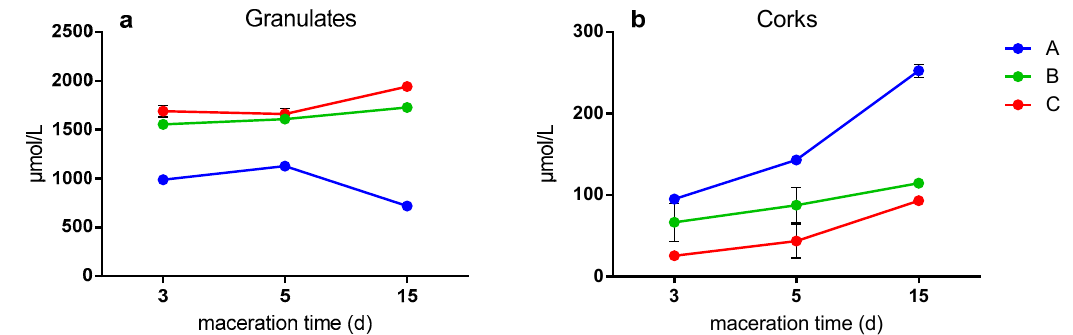
Figure 5. Antioxidant activity of granulates ( a ) and cork ( b ) samples determined by ABTS method (expressed in µmol/L of Trolox reagent), note difference in y -axis scales. Particle size from cork stoppers and their respective granulates, A; high, B; medium, C; small.